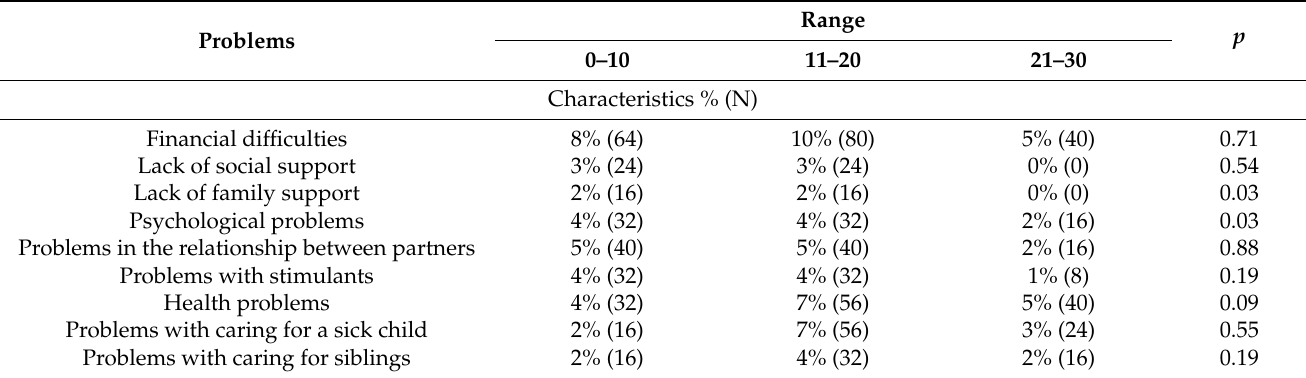
Table 4. Assessment of